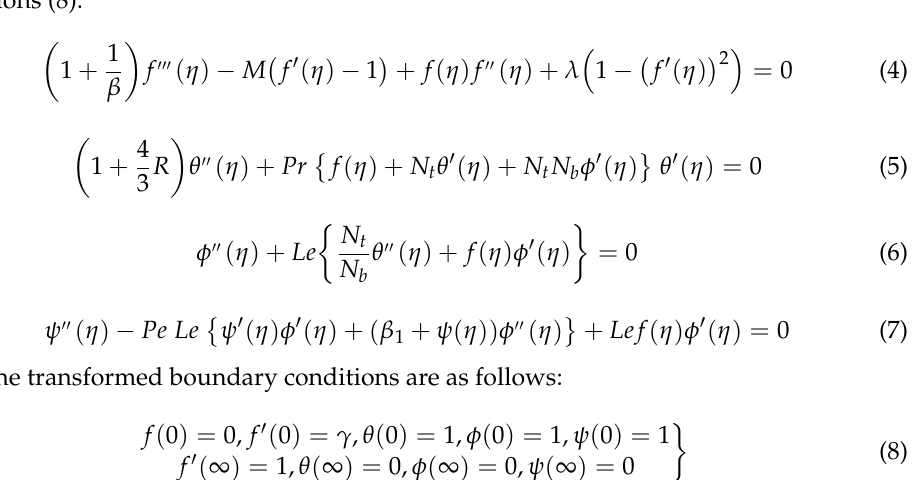
Figure 1. Physical con fi guration of Falkner–Skan fl ow model.